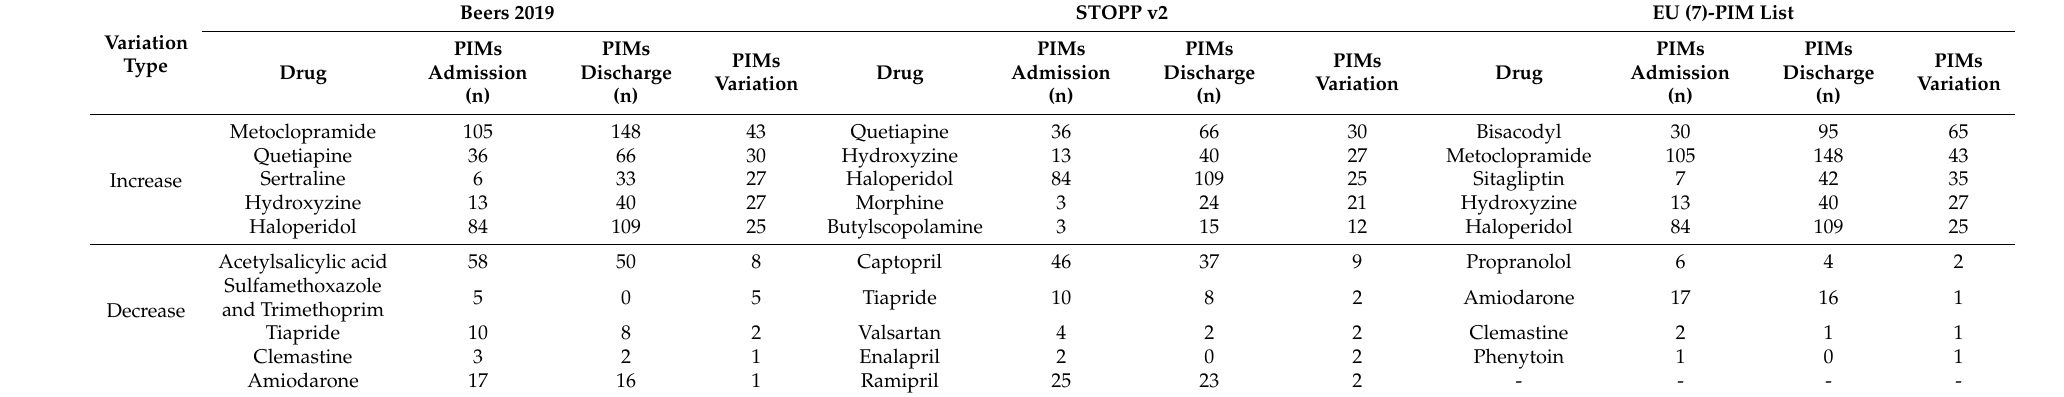
Table 3. PIMs’ increase and decrease from admission to discharge according to the Beers and the STOPP criteria and the EU (7)-PIM